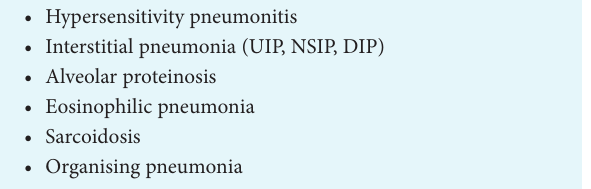
Table 2. Peripheral/patchy GGO